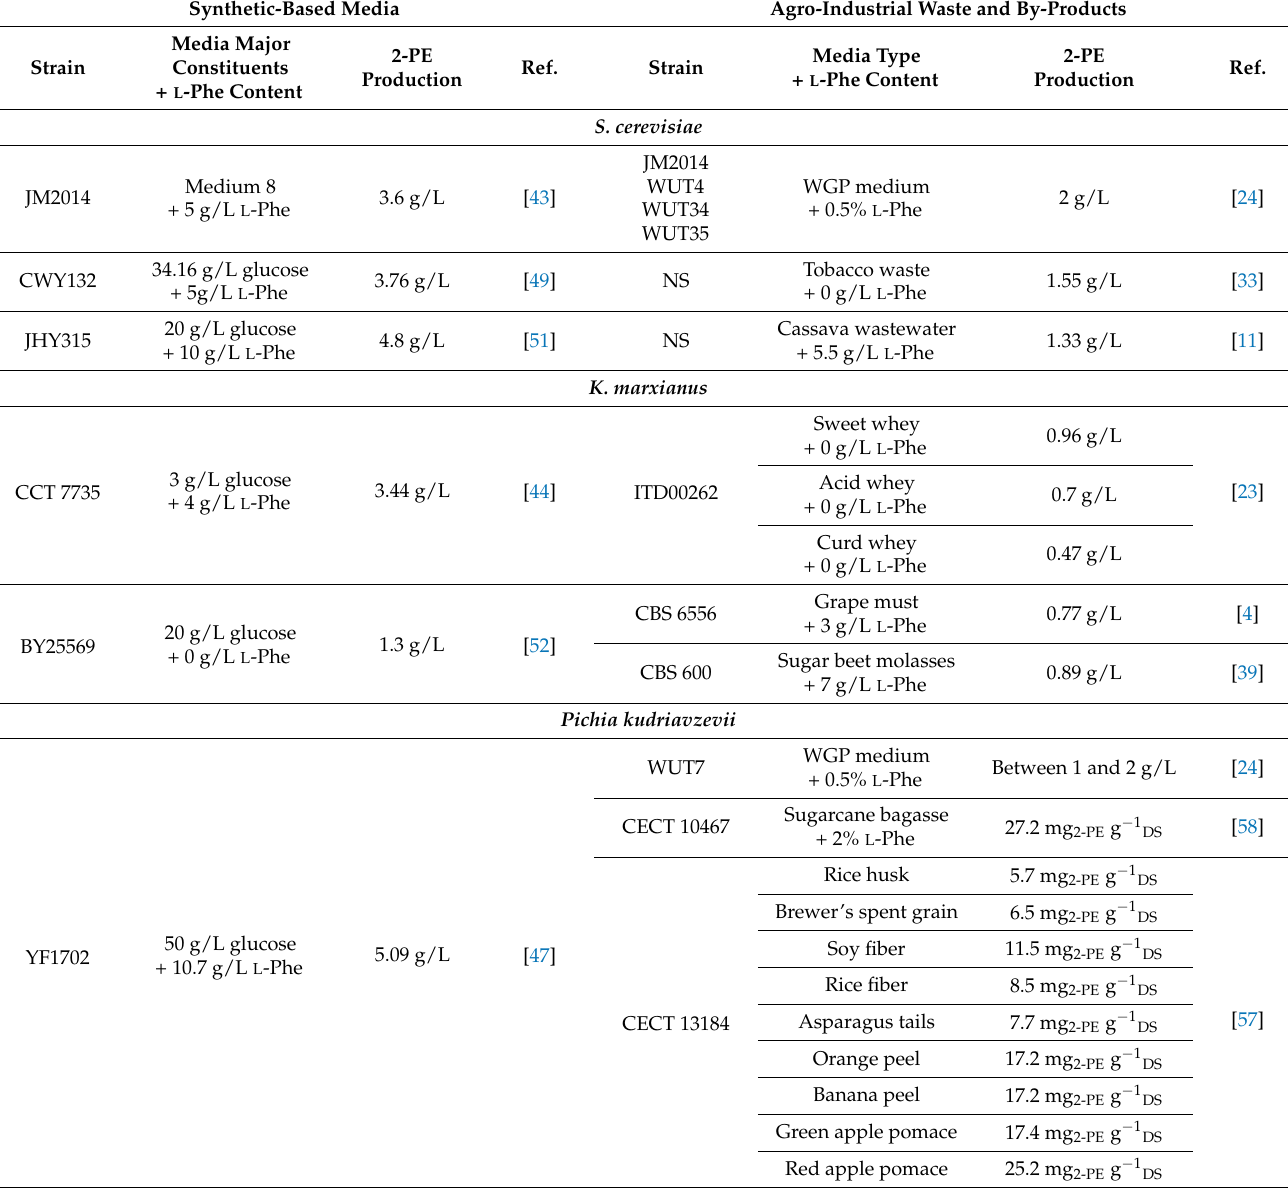
Table 2. Comparison of 2-PE production capacity of different yeast species on synthetic media versus agro-industrial waste